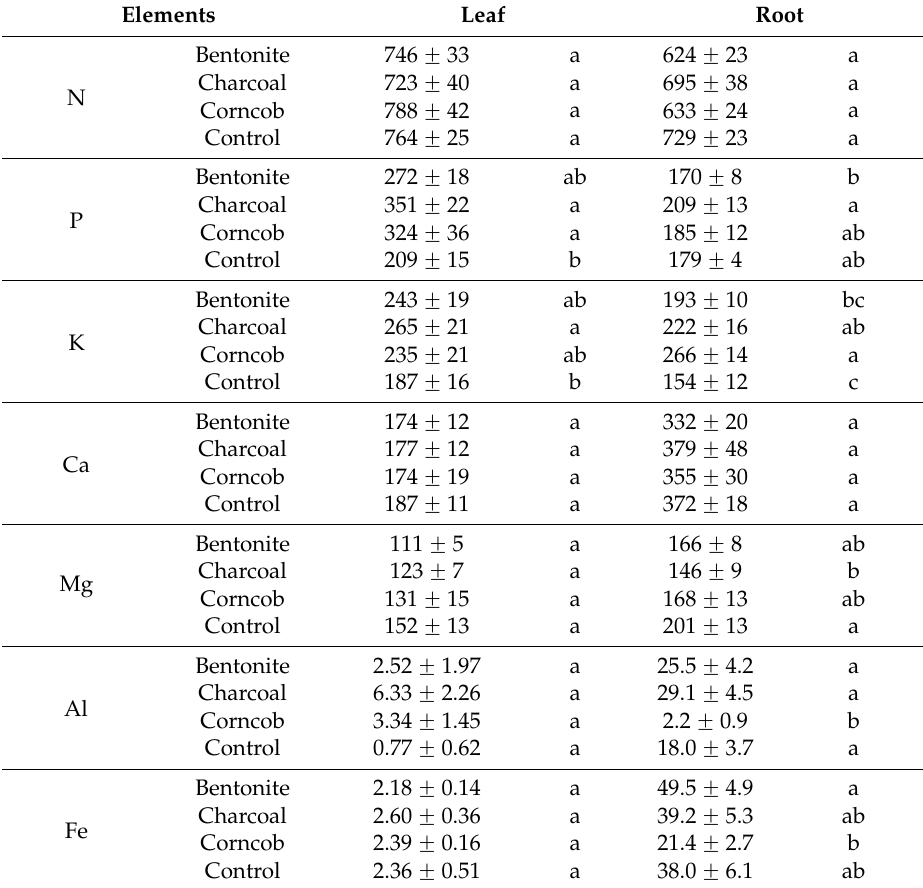
Table 3. Concentrations of elements (N, P, K, Ca, Mg, Al, and Fe; µ mol ¨ g ´ 1 DM) in leaves and roots of teak seedlings grown in four treatments (Mean ˘ SE, n =